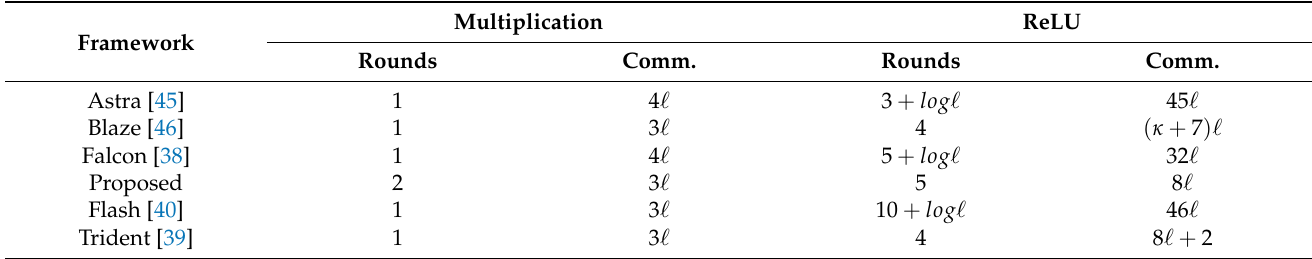
Table 2. Comparison of theoretical complexity of sub-protocols in each